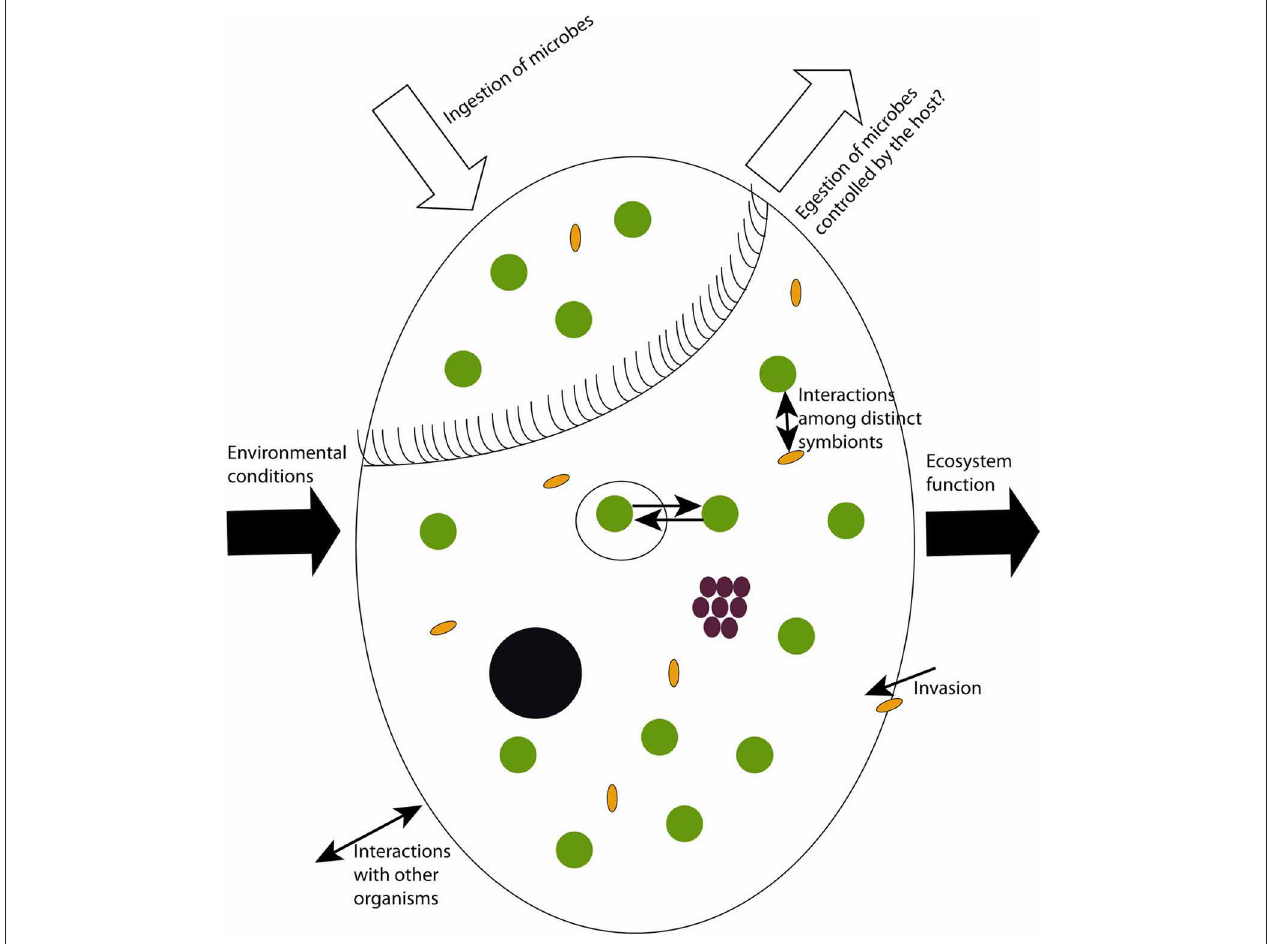
FIGURE 1 | Sketch of possible dynamics in symbioses with aquatic ciliates as host. Black circle = macronucleus, white big circle = food vacuoles, green circles = phototrophs, brown circles = chemoautotrophs,yellow ovals = heterotrophic